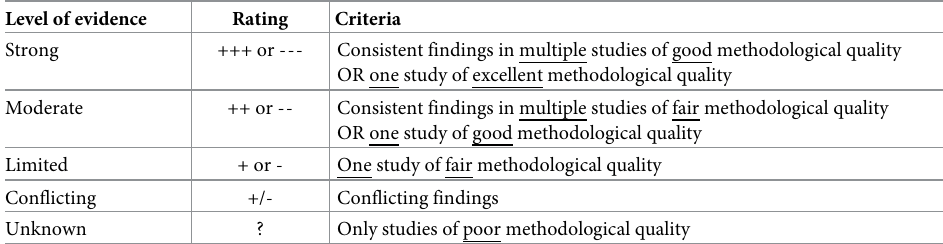
Table 4. Levels of evidence for the best-evidence